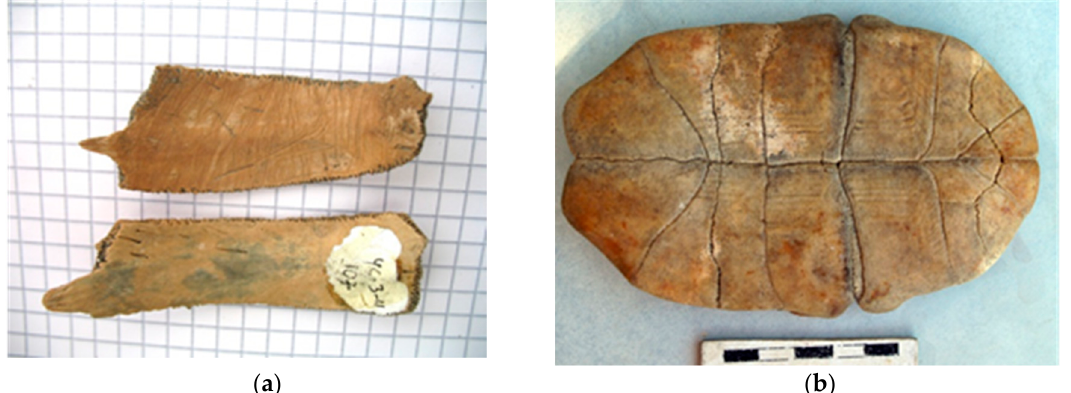
5 of 11 Figure 1. Map of subfossil records (from VII BP to XII AD: Ukraine, Russia) of E. orbicularis (Table 1). Individual fragments and single specimens were more common, but accumulations of bone remains were found in the Lipetsk region (Russia), 243 specimens in one place, and in the Luhansk region (Ukraine), 272 individuals, and 748 individuals in two places. Such unique findings of remains’ clusters are most likely explained by culinary preferences, and possibly the traditional uses of turtles not only for culinary, but also for other practical purposes: sometimes turtle’s carapace was used as a dish or decoration. Such traditional exchanges of turtle artifacts or pets between human settlements could lead to the appearance of turtle remnants or even live animals in the most unusual places. However, only suitable climatic conditions can support the survival of alien turtles in a natural habitat. Therefore, it is necessary to analyze, not only the findings of turtles themselves, but also the climatic conditions of those distant ages while using paleoclimatic data. When comparing our unique archaeological findings with the modern distribution of pond turtles, we came to the conclusion that turtles that were found around the Black Sea and on the adjacent islands (Berezan, Olbia of Mykolaiv region, Ukraine) are of particular interest [34]. Today,